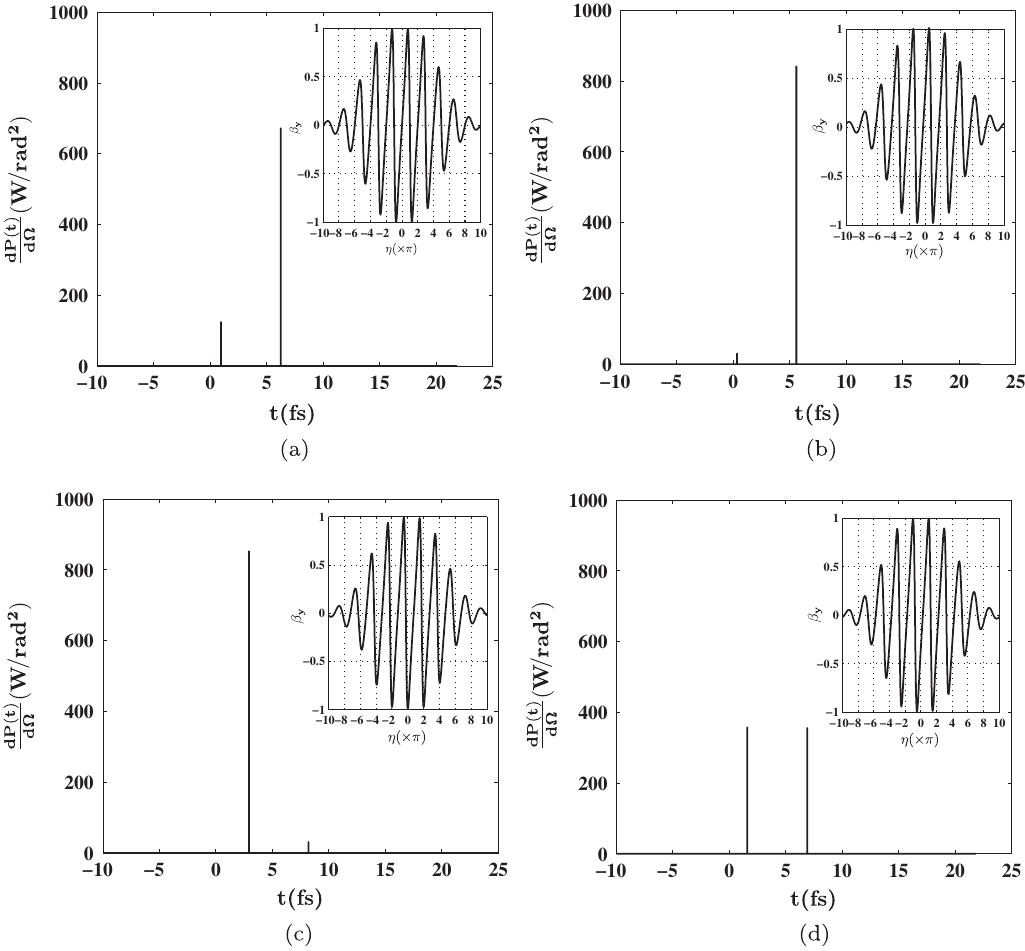
FIG. 7. The time histogram of the radiation power per solid angle along the þ y axis by an electron scattering with a circularly polarized laser pulse. The insets show the normalized velocity (cid:8) y of the electron in the laser field as a function of (cid:1) . (a) (cid:3) 0 ¼ 0 , 5 7 (cid:4) , (c) (cid:3) (cid:4) , (d) (cid:3) (cid:4) . All of the other parameters are the same as those in Fig. (b) (cid:3) 0 ¼ 1 0 ¼ 0 ¼ 4 4 4